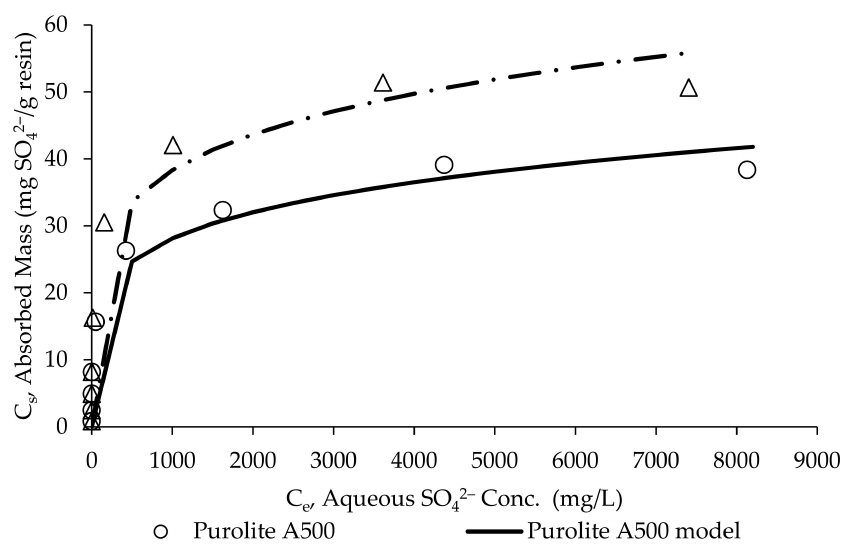
Figure 6. Adsorption isotherm of SO 4 − on Purolite A500 and Purolite A300 resins with a Freundlich model